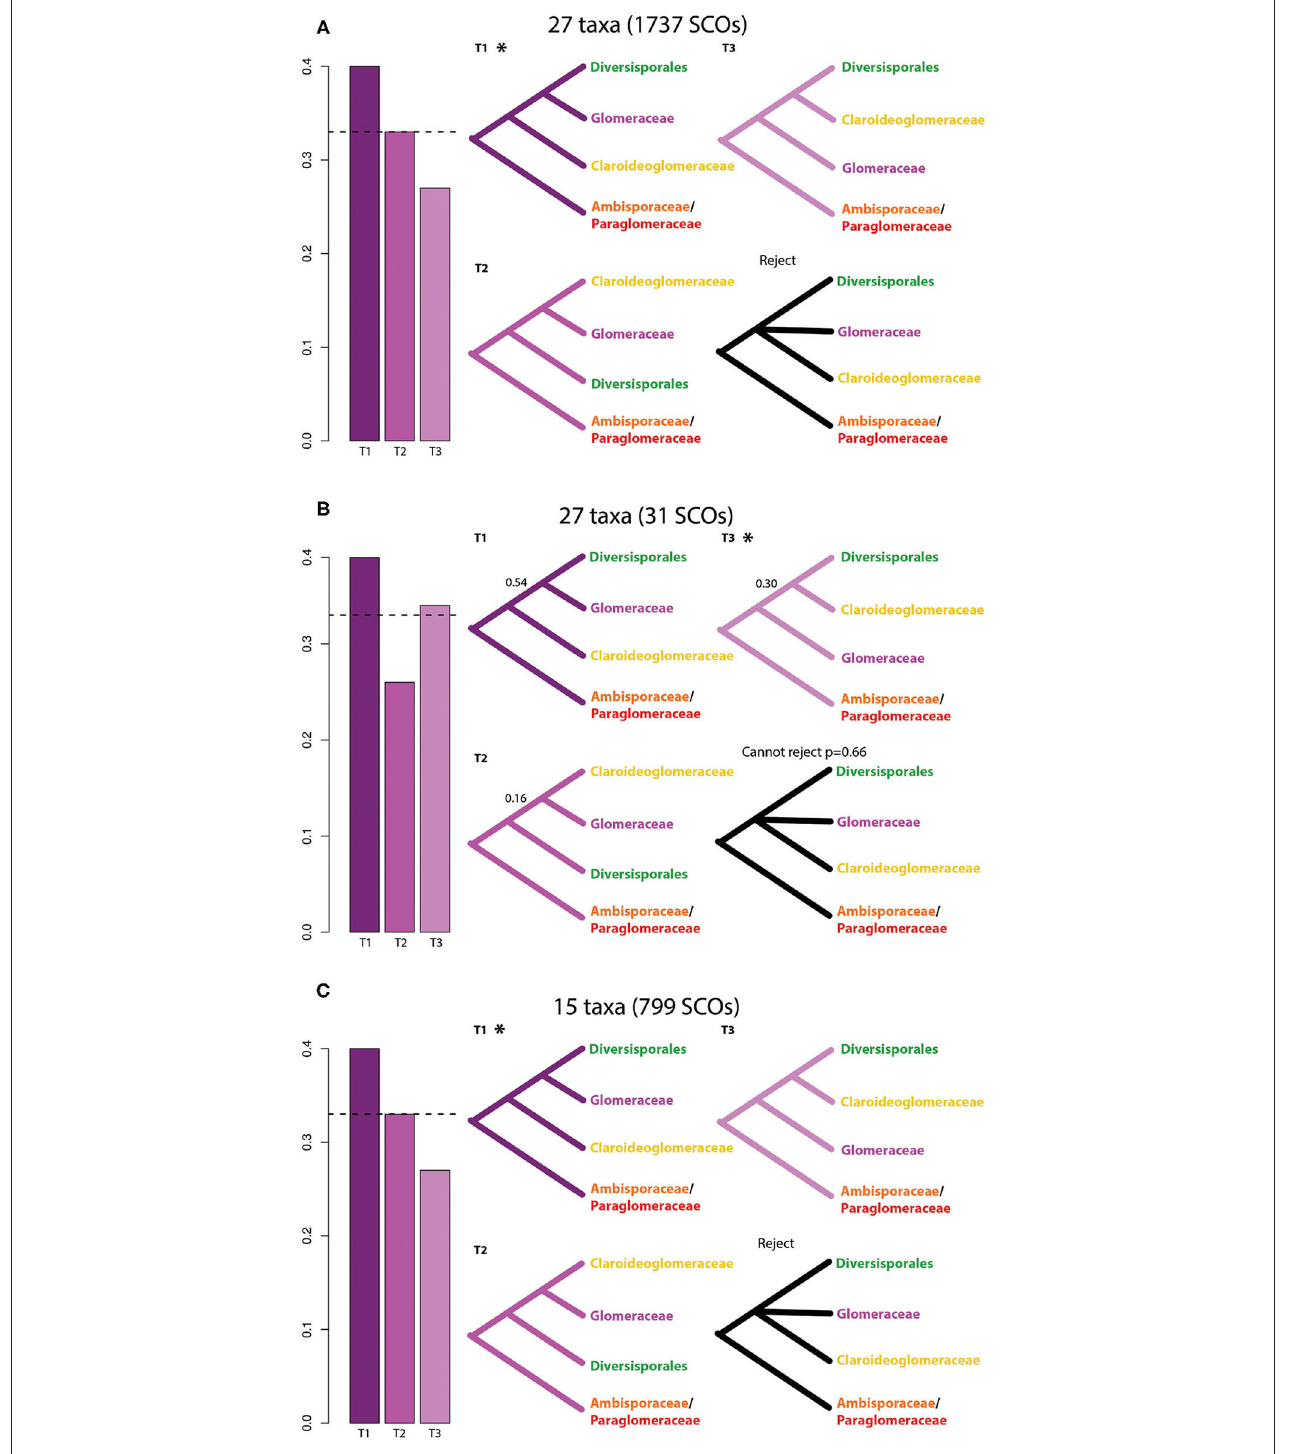
FIGURE 2 | Evaluation of support among individual gene trees for alternative hypotheses of the relationships within Glomeromycota based on three datasets. (A) Glomeromycota dataset with single copy orthologs (SCOs) that are present in > 50% of the taxa (27 taxa/1737 SCOs). (B) Glomeromycota dataset including SCOs that are present in all the taxa (27 taxa/31 SCOs). (C) Glomeromycota dataset with a selection of 15 taxa (see methods and Supplementary Table 4 ) including SCOs that are present in all taxa. Bar graphs represent the gene tree quartet frequencies for three possible branching orders within Glomeromycota. T1 corresponds to the ASTRAL topology, T2 and T3 correspond to alternative topologies in ASTRAL. Dashed horizontal lines marked the expectation of a hard polytomy. The topologies inferred with the concatenation-based method (Maximum Likelihood) are marked with an asterisk (*). Local posterior probabilities are indicated only when below 1.0.